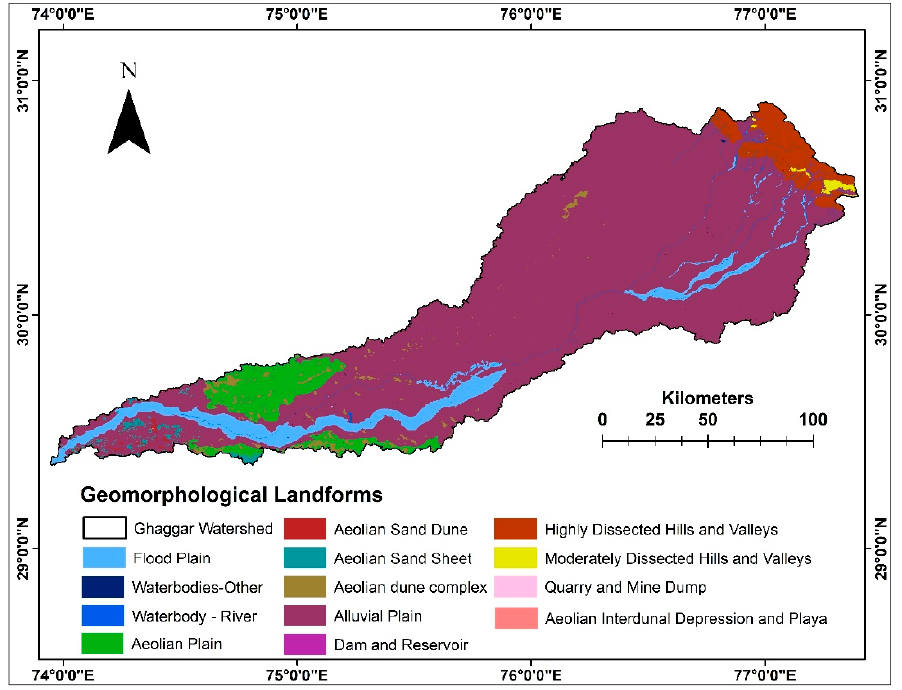
Figure 3. Geomorphological map (Source: Geological Survey of